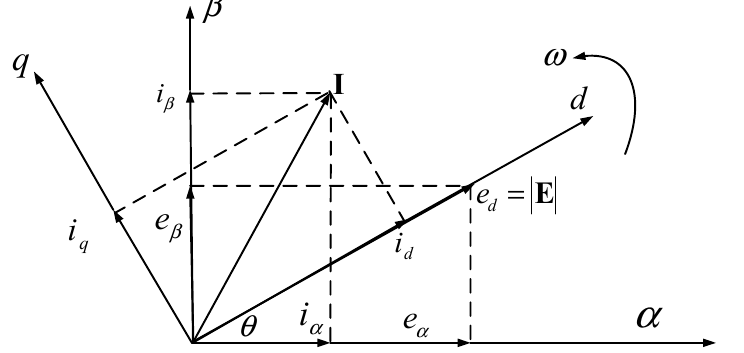
Figure 2. Grid-connected inverter voltage and current vector diagram under α − β and d–q coordinates.